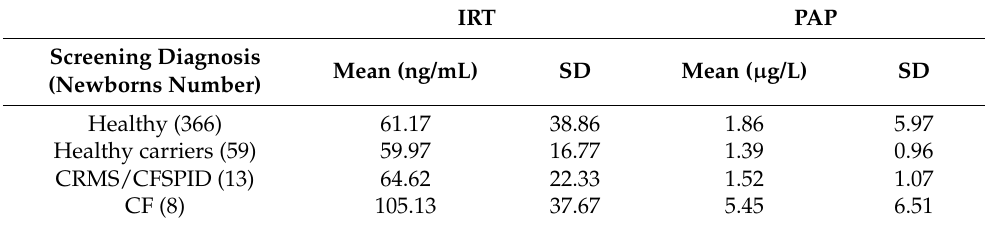
Table 3. Mean IRT and PAP value in healthy subjects, healthy carriers, CRMS/CFSPID, and CF